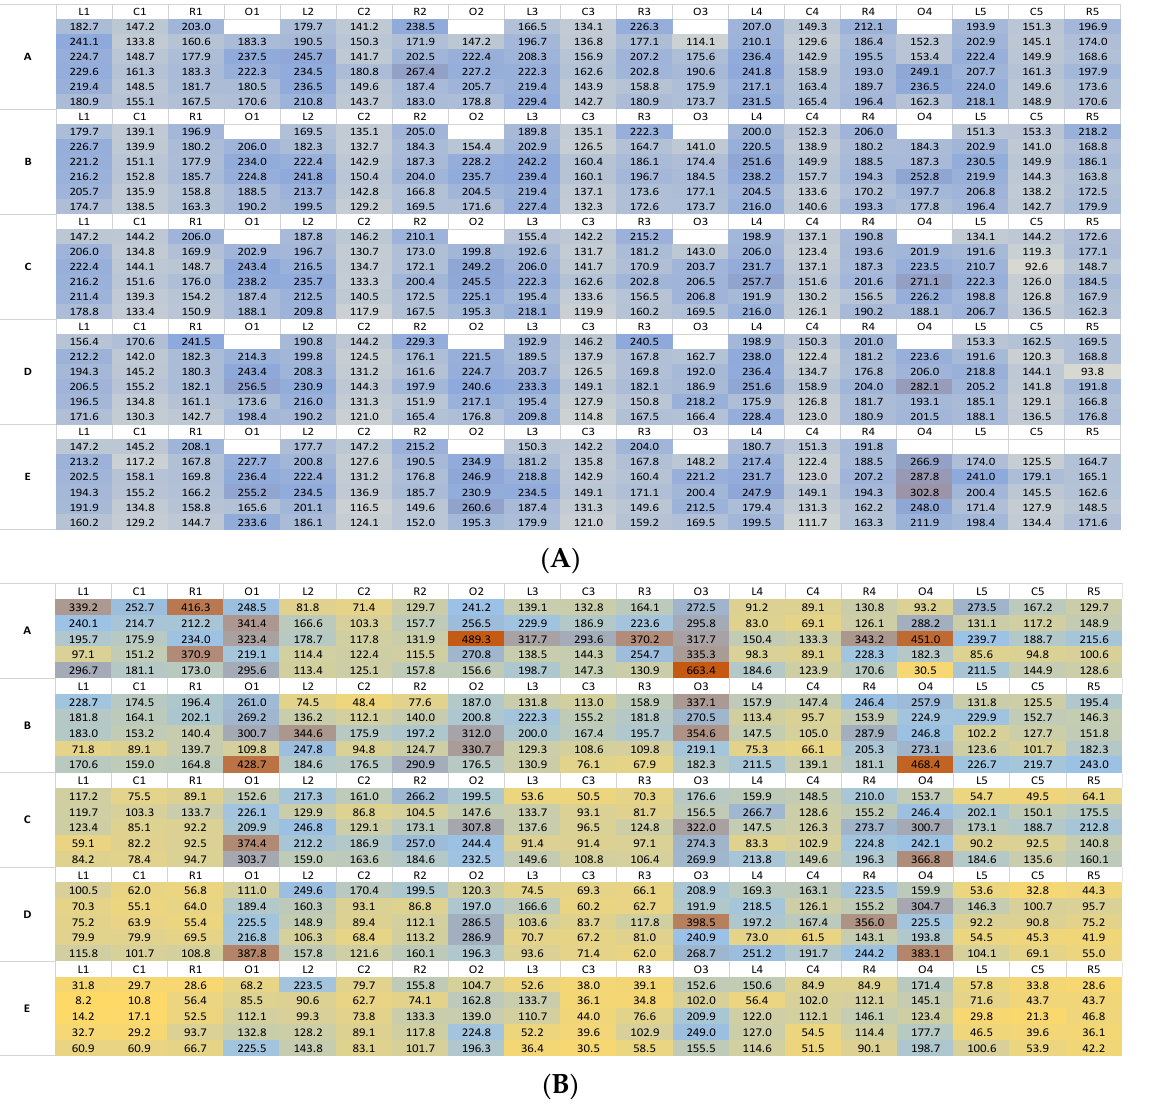
Figure 2. Heat maps of fluorescein deposition on wall surfaces using an automated track ( A ) and manual ( B ) spray. Filter papers to collect fluorescein deposited by each spray type were attached to walls in the configuration shown. Five swaths were present on each wall, measured at the Left (L), Centre (C), Right (R), and Overlap (O) positions. Letters A – E indicate the height position down the wall. Six trials were performed for the track spray and five were performed for the manual spray. Individual cells show the corrected fluorescence values for each spray trial replicate. Orange indicates higher fluorescein values, blue indicates midpoint values, and yellow indicates low values. A far higher degree of variation in fluorescein deposition is apparent in the manual spray compared to the track spray.